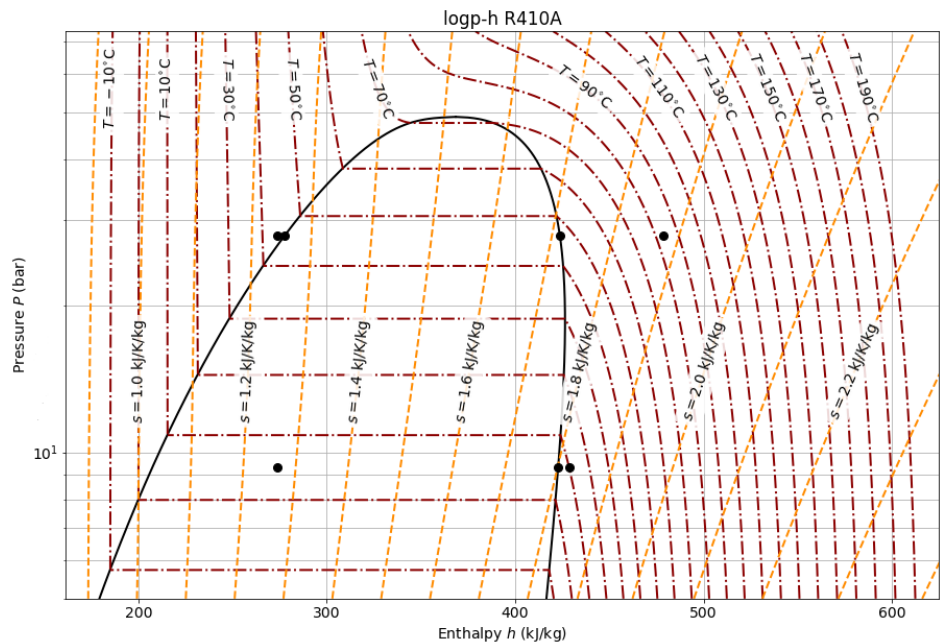
Figure 5. Characteristic points for R410A refrigerant cycle generated by the Python script for source temperature equal to 5 °C and sink temperature of 45 °C.